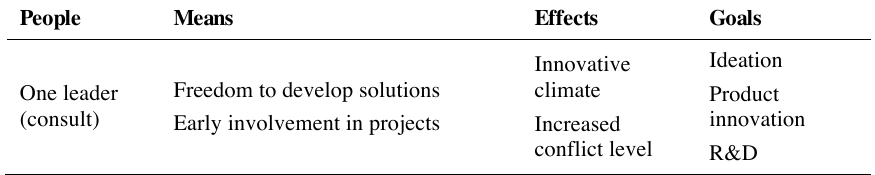
Table 1. Profile of existing research on directive leadership (LS1a). People Means Effects Goals Controlling, monitoring, instructing, hierarchical influence One leader (direct) Providing a framework for decision making and action Table 2. Profile of existing research on participative leadership (LS1b). People Means Effects Goals Freedom to develop solutions One leader (consult) Early involvement in projects